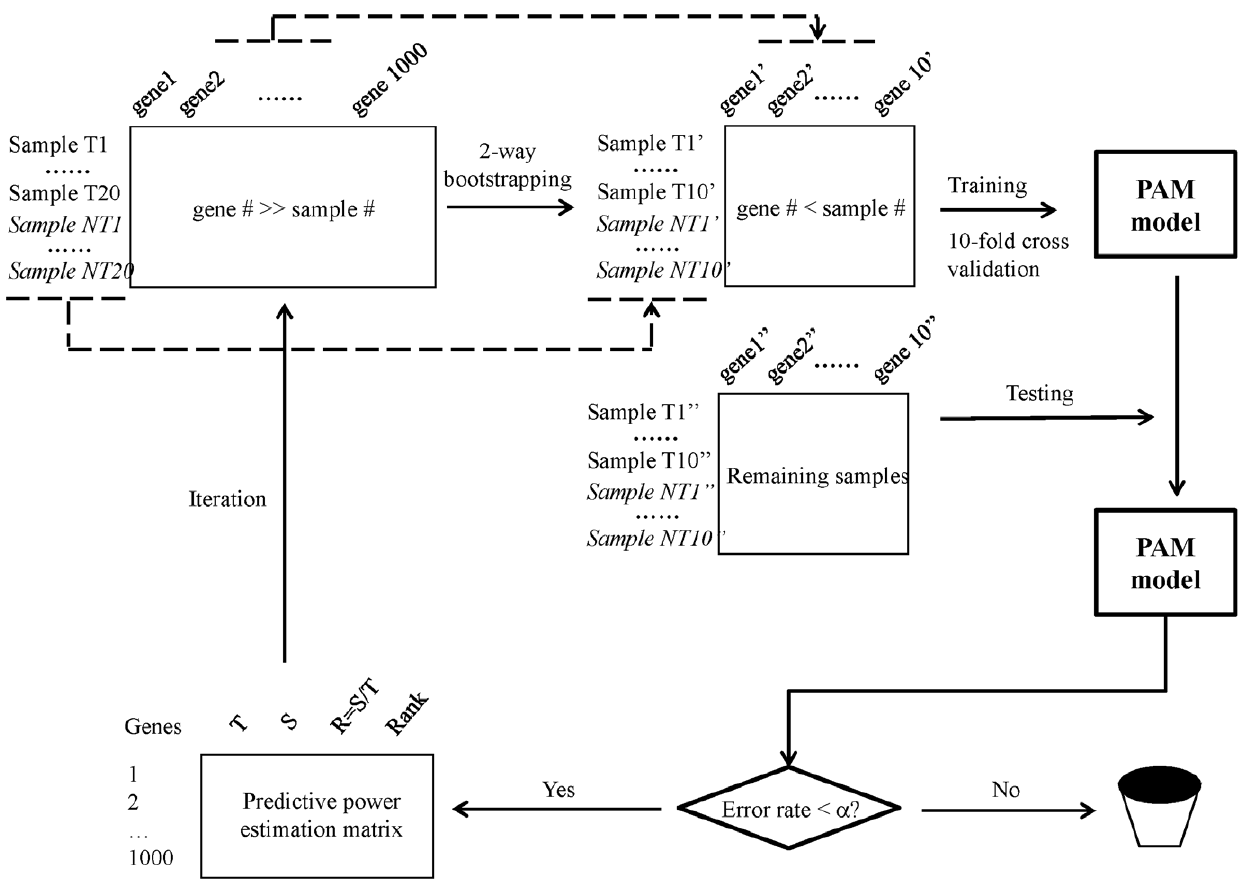
Figure 1. Schematic representation of PPEA algorithm. Assumptions used in the schema are (1) the original data matrix consists of (20 toxic and 20 non-toxic samples) x1000 genes, and (2) a 2-way bootstrapping sample consists of 10 toxic and non-toxic samples (i.e. K splitting ratio) and 10 genes.